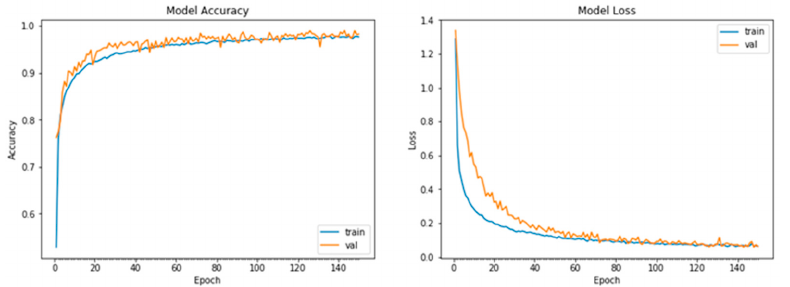
Figure 2. Plot of best-performing ADAM with increasing CNN width for Natural Images.